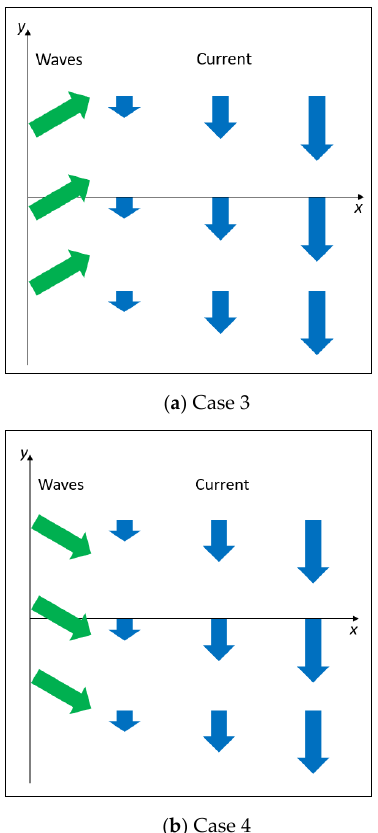
Figure 5. Schematic of wave propagation and current velocity directions for cases 3 and 4.